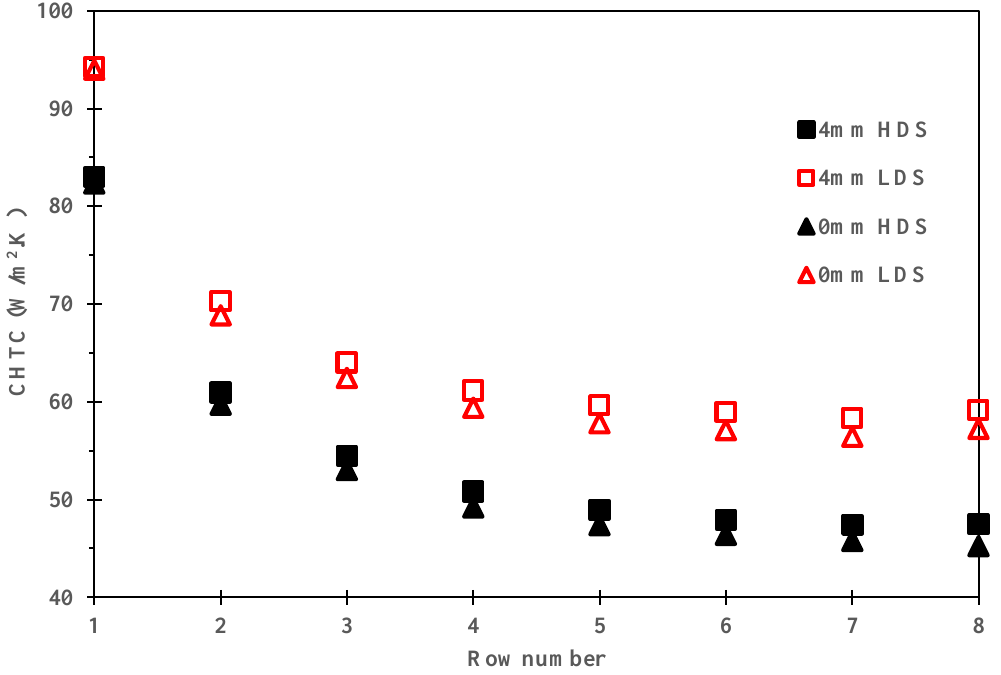
Figure 8. CHTC values for two kiln boundary roughness levels for the HDS and LDS.